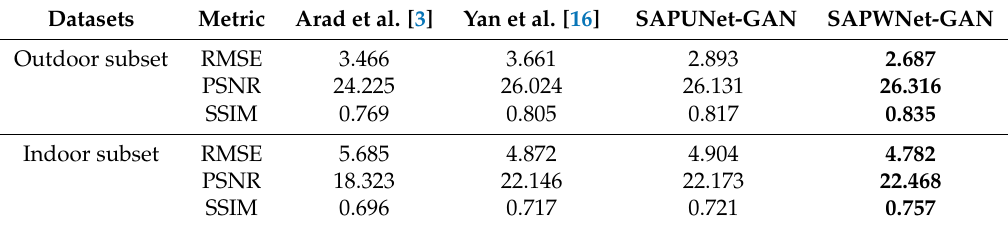
Table 3. The quantitative results on the dataset